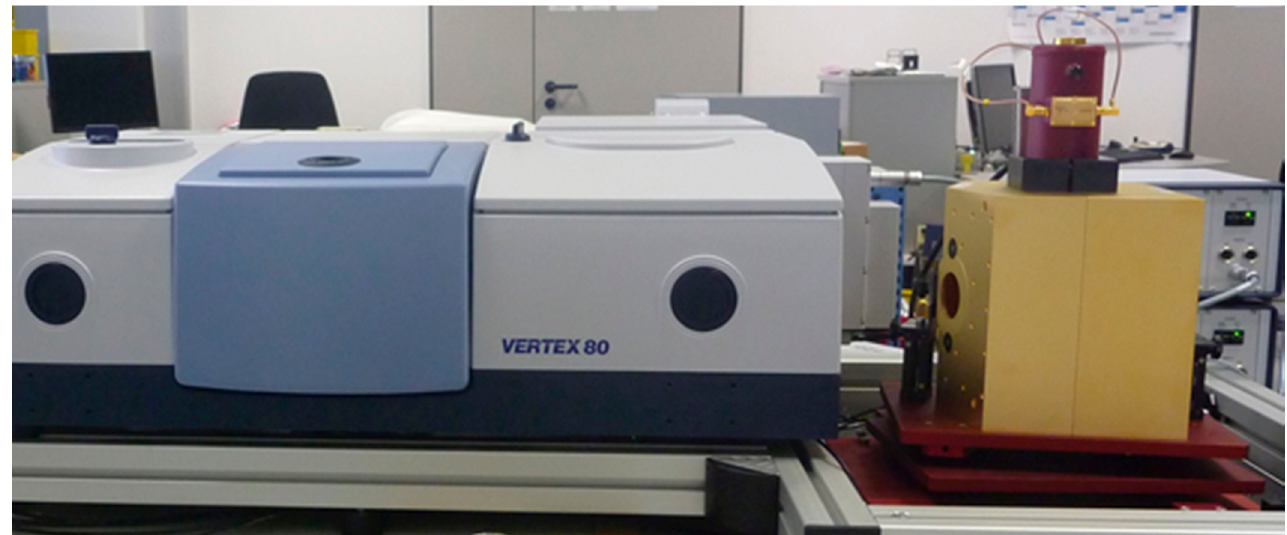
Figure A4. The set-up applied by Optosol GmbH, based on a Bruker VERTEX 80.